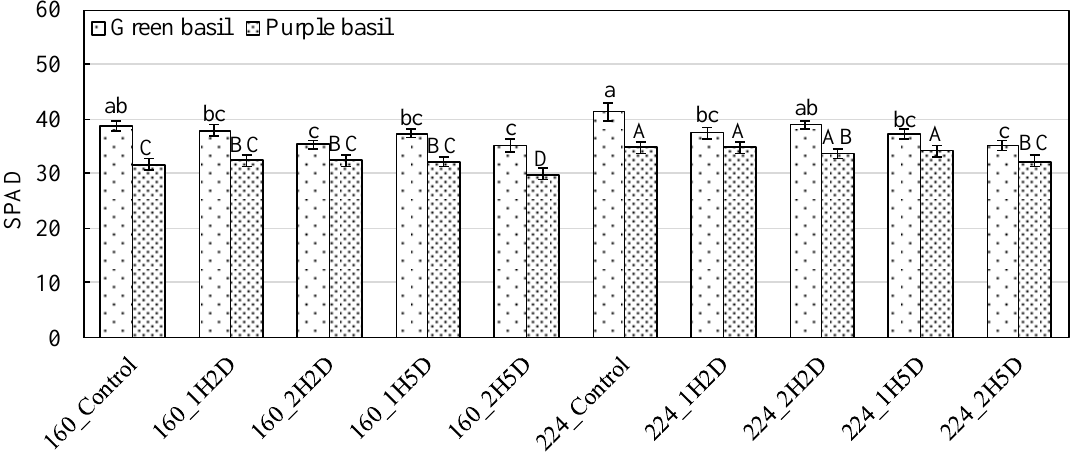
Data were pooled from two photosynthetic photon flux density (PPFD) treatments. z Means followed by the same lower/upper case letters are not significantly different for green/purple basil plants, according to Student’s t mean comparison ( p < 0.05).